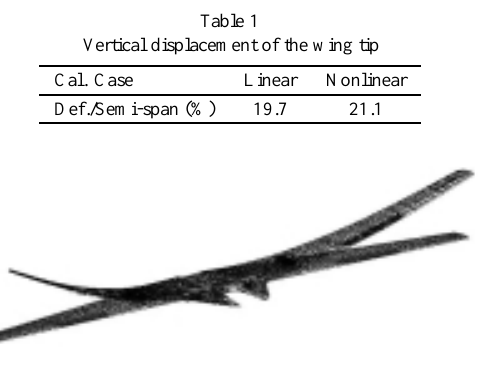
Fig. 1. Finite element mesh of the wing and its nonlinear